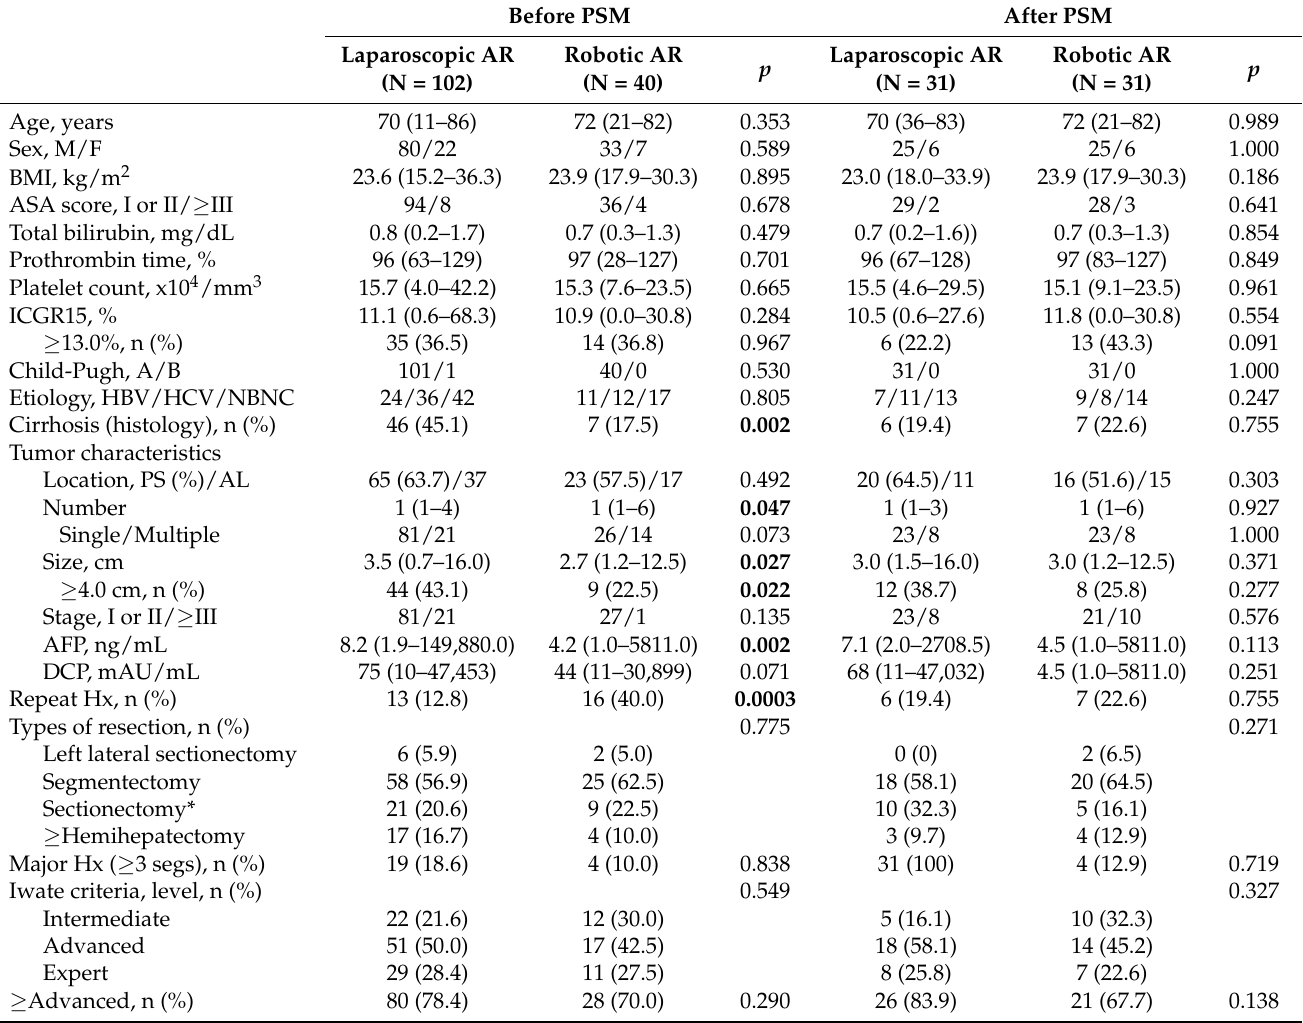
Table 3. Comparison of baseline data between laparoscopic and robotic AR for HCC.